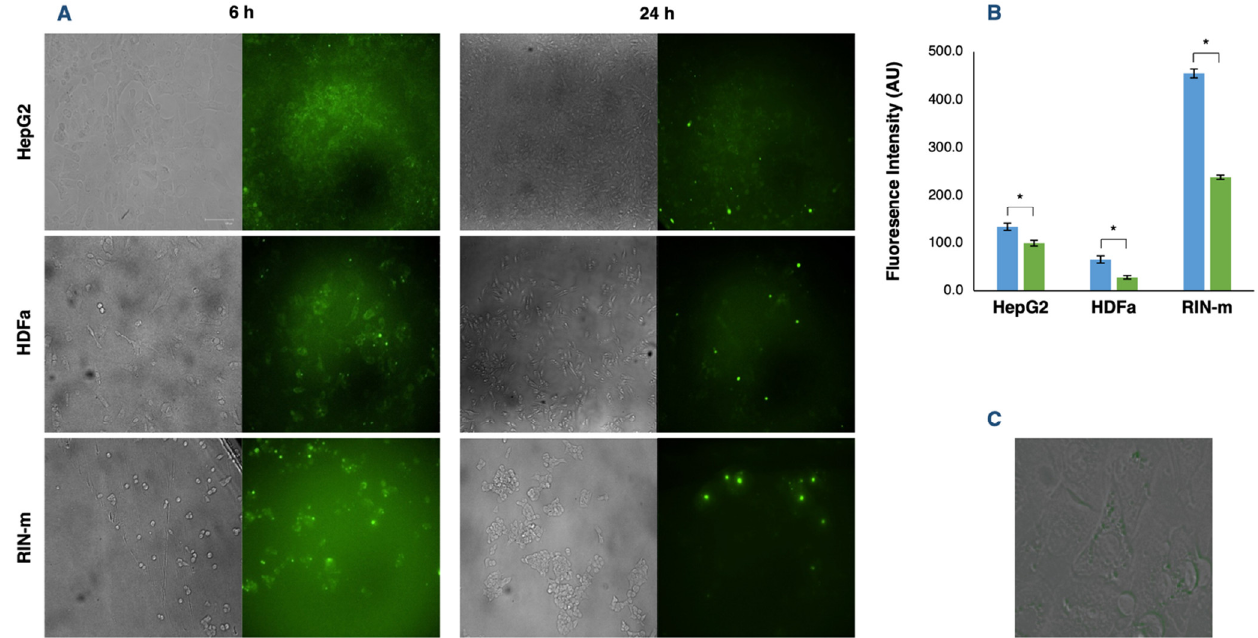
Figure 4. Exosome uptake by HepG2, HDFa and RIN-m cells. ( A ) Fluorescence microscopy images of HepG2, HDFa and RIN-m cells incubated with their respective exosomes loaded with FITC–insulin after 6 and 24 h. ( B ) Fluorescence intensity quantification after 6 (blue bars) and 24 h (green bars). The bars represent the mean intensity and the standard error. * Significant differences between treatments (Student’s t -test; p < 0.05). ( C ) Fluorescence microscopy image of an HDFa cell 6 h after exosome co-incubation. Loaded exosomes can be visually located inside the cytoplasm, dispersed between the cytosolic side of the plasma membrane and the perinuclear region.